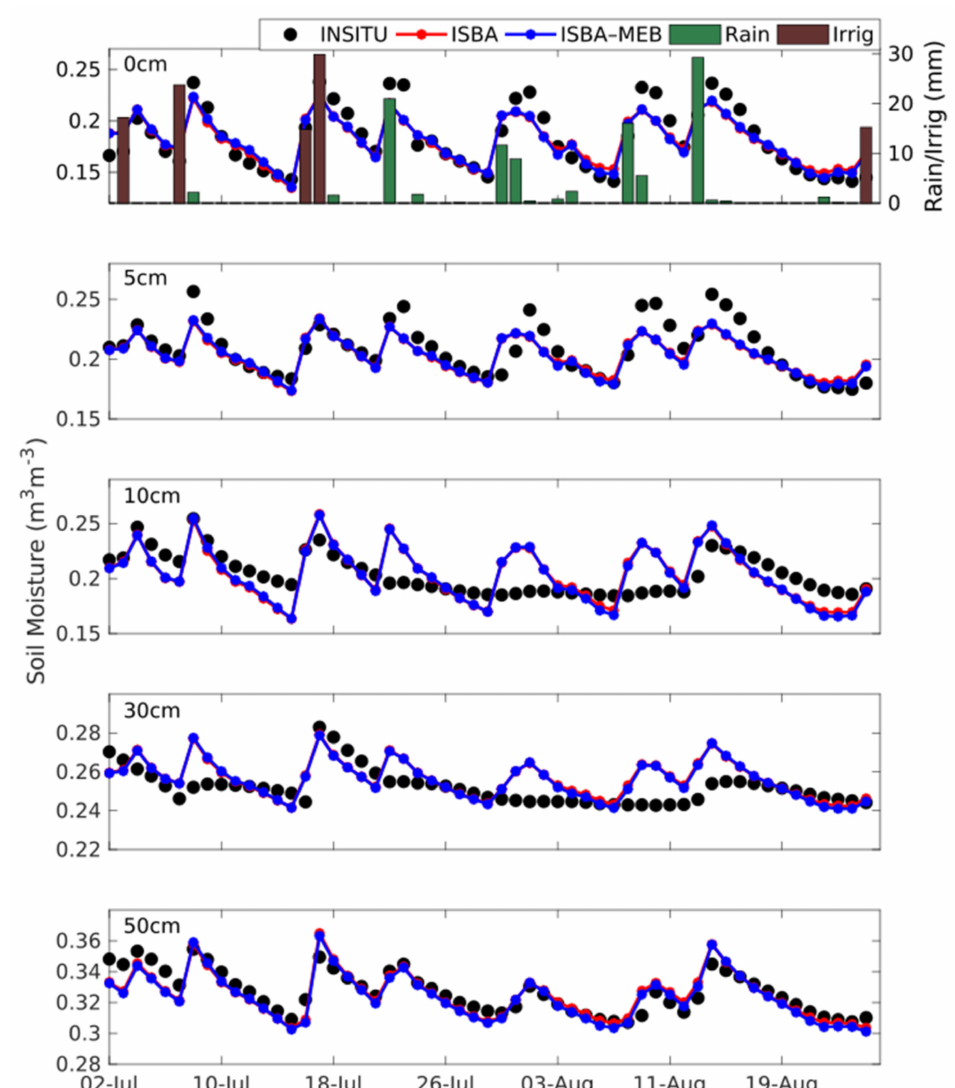
Figure 8. Daily time series of the in situ soil moisture compared with the estimates of ISBA and ISBA-MEB at 0, 5, 10, 30, and 50 cm coupled with the total rainfall (+irrigation) from 1 July 2015 to 31 August 2015 during the sap flow campaign